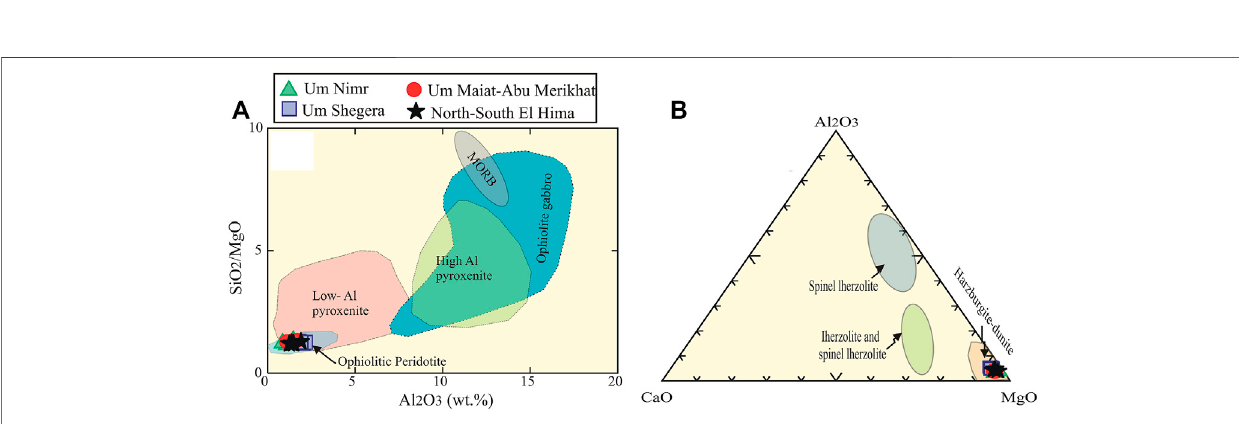
the dark blue pixels of biotite gneisses and pinkish-gray color of gneissose granodiorite. The pegmatite veins and bodies exhibit orange color. The band ratio RGB-11/7, 12/5, 11/12 of (S2A) ( Figure 4D ) shows the ultrama fi cs in lemon green, gneisses in bright green, the highly injected white gneissic granodiorite with pegmatites in blue colors. The pegmatites are demarcated by the light magenta color. The Chica-Olma ratio RGB-6/7, 6/5, 4/2 of (L8) ( Supplementary Figure 2C ) highlights the ultrama fi cs rocks in reddish yellow, gneisses in dark green, gneissic granodiorite- tonalite in light violet to dark blue color. The pale yellow color of pegmatite bodies can be detected well from the dark background colors of gneissic granitic rocks. In addition, the ultrama fi c rocks in the six studied areas of Um Maiat, Abu Merikhat, Um Nimr, North El Hima, South El Hima, and Um Shegera exhibit bright